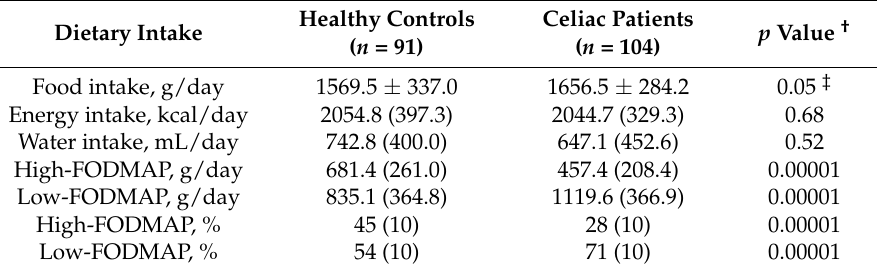
Table 2. Daily dietary intake of celiac patients and healthy controls.